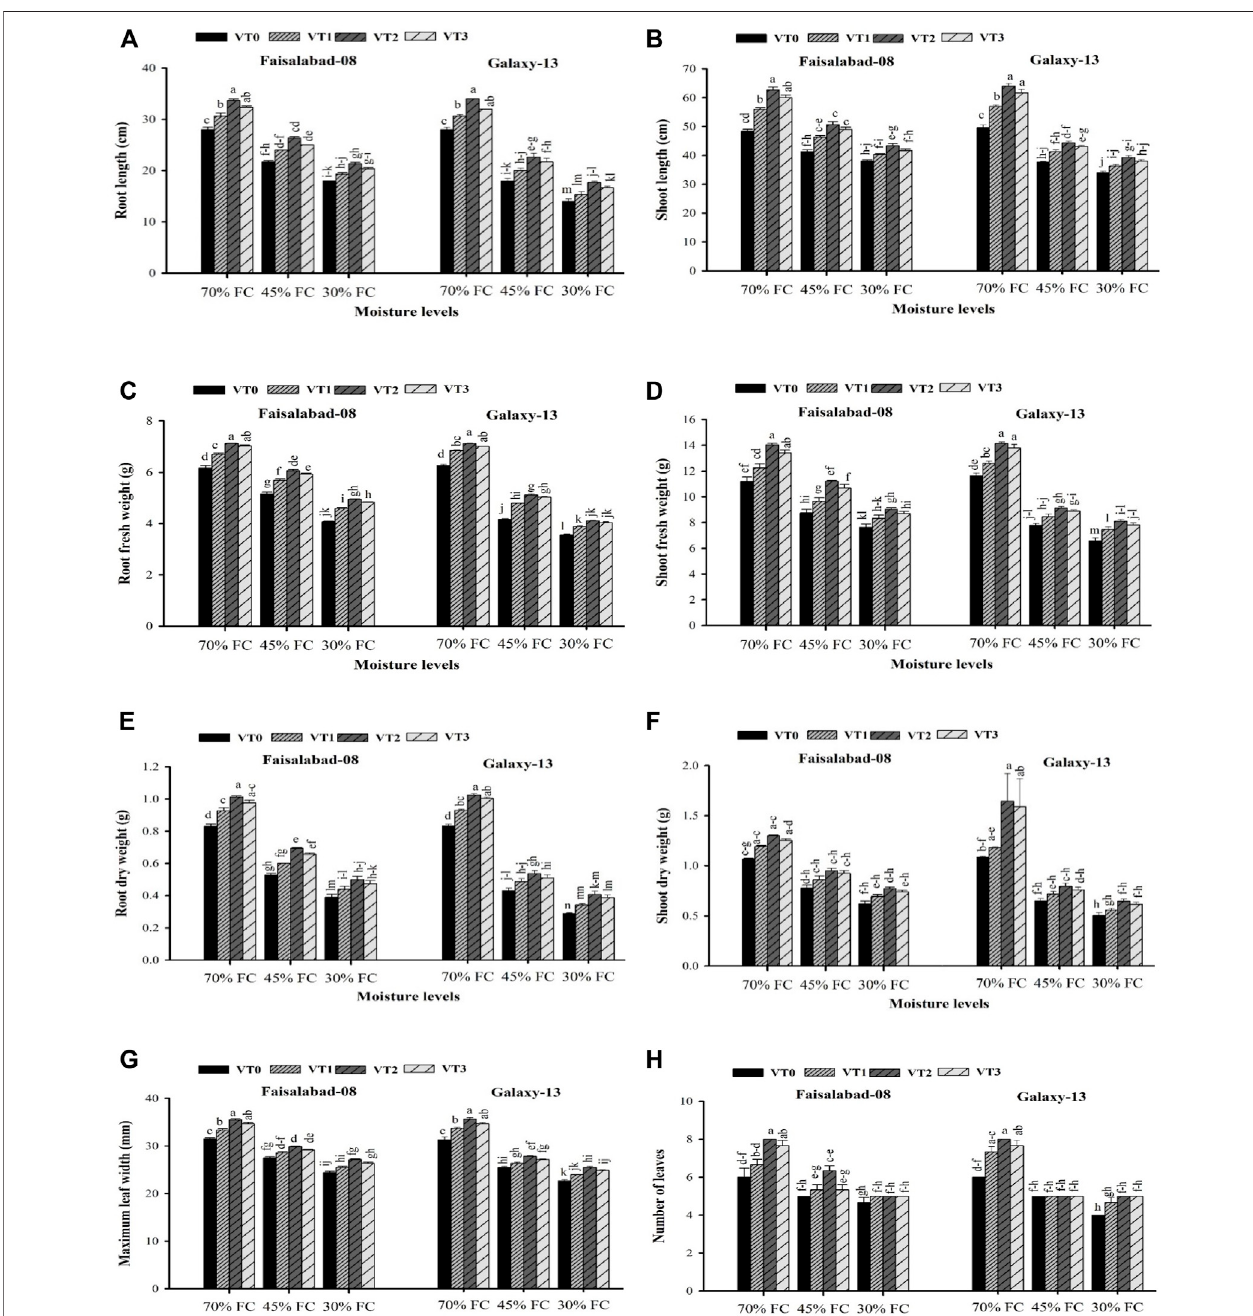
FIGURE 3 | Effect of soil-applied cellulolytic microbe-enriched rice straw vermicompost on root length (A) , shoot length (B) , root fresh weight (C) , shoot fresh weight (D) , root dry weight (E) , shoot dry weight (F) , maximum leaf width (G), and number of leaves (H) of the two wheat cultivars Faiasalabd-08 and Galaxy-13 under differentdroughtlevels,well-wateredcondition(70% fi eldcapacity-FC),moderatedrought(45%FC),andseveredrought(30%FC).Barswithdifferentsmalllettersshow signi fi cant differences at a 5% probability level according to Tukey ’ s HSD test.